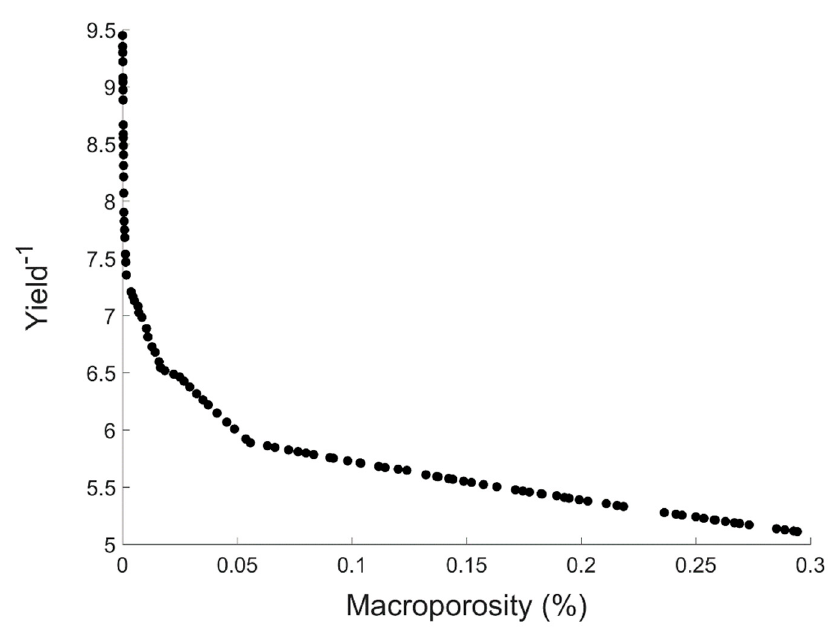
Figure 6. Pareto front of yield vs macroporosity.